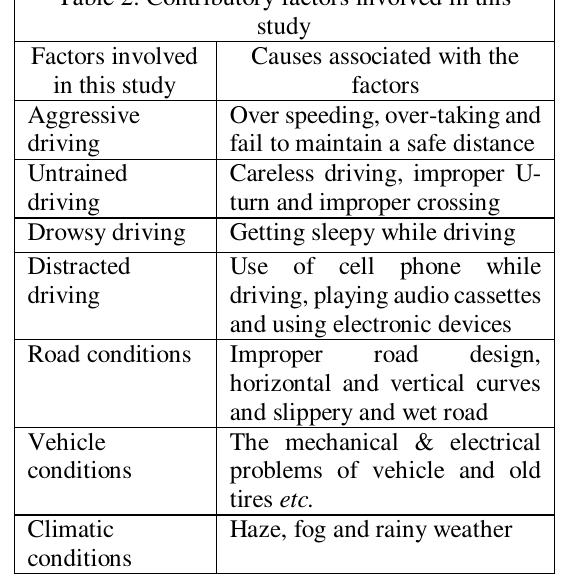
Table 2: Contributory factors involved in this